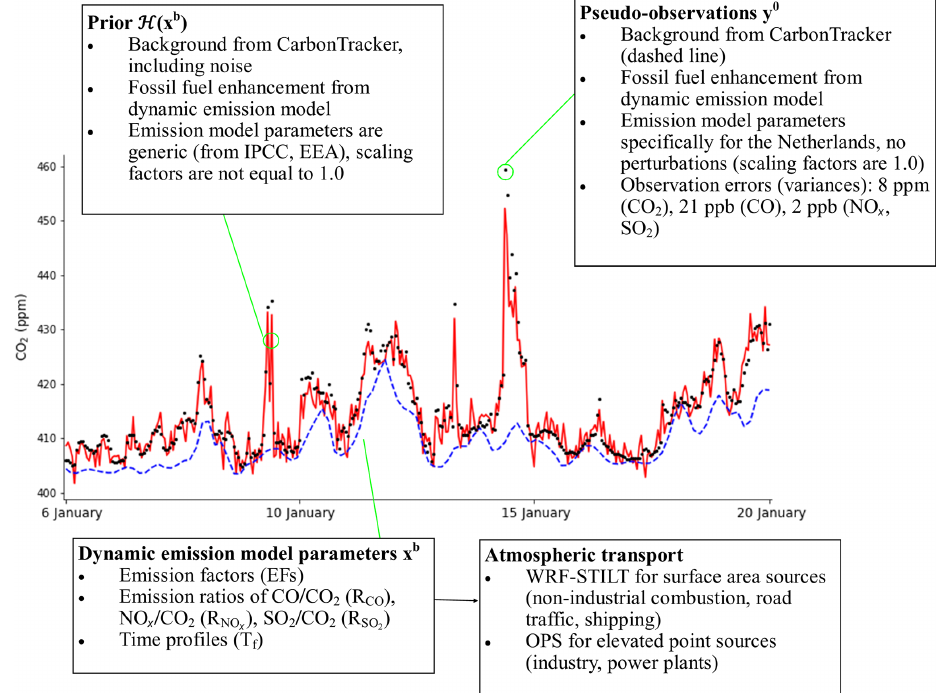
Figure 7. Time series of pseudo-observations and prior CO 2 mole fractions and a summary of how these time series were